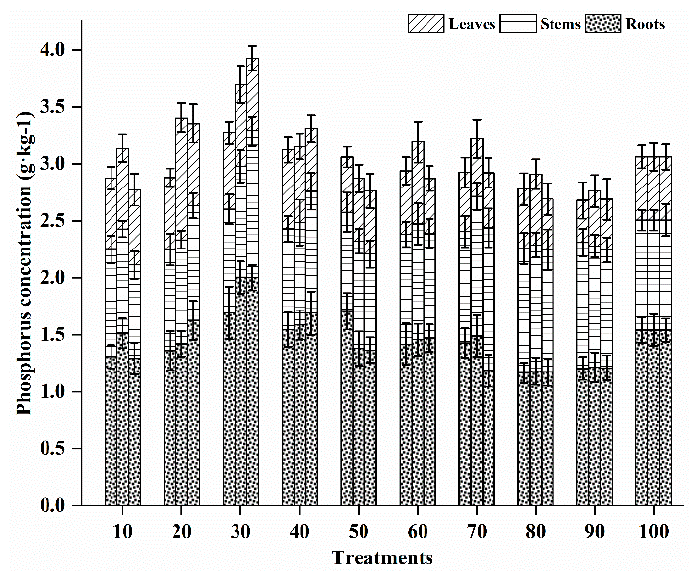
Figure 7. Phosphorus distribution in different vegetative tissues (Note: There are three linked bars: four fertilizer applications on the left, six fertilizer applications in the middle, and eight fertilizer applications on the right).